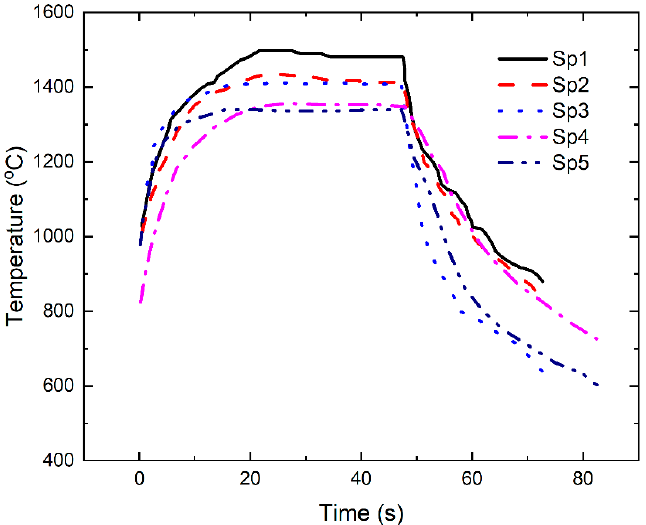
Figure 8. The temperature change with time for five different measurement spots during thermal shock test of left guide vane. shock test of left guide